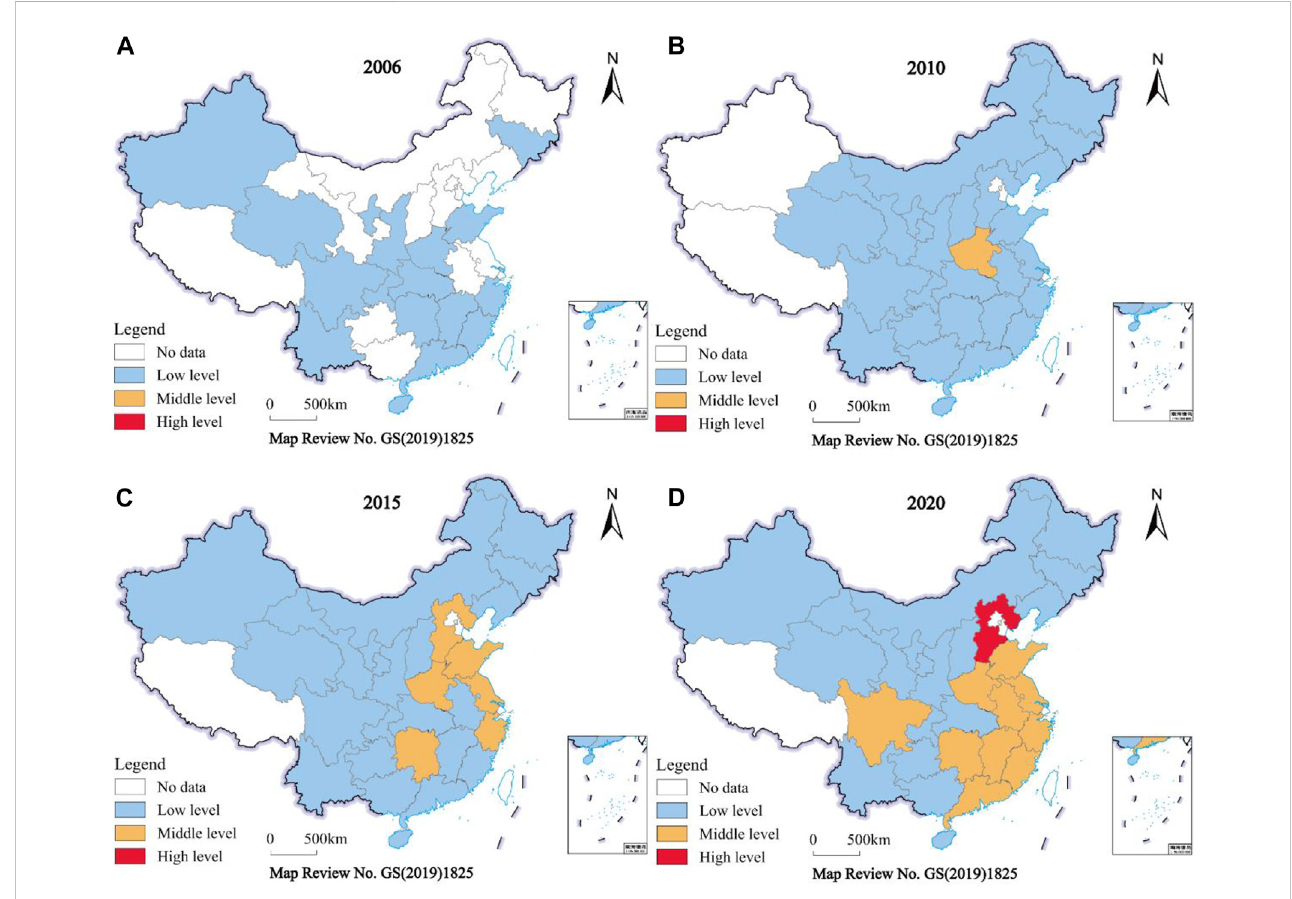
FIGURE 2 Spatial distribution of county solid waste harmless disposal capacity by province in China (from (A – D)